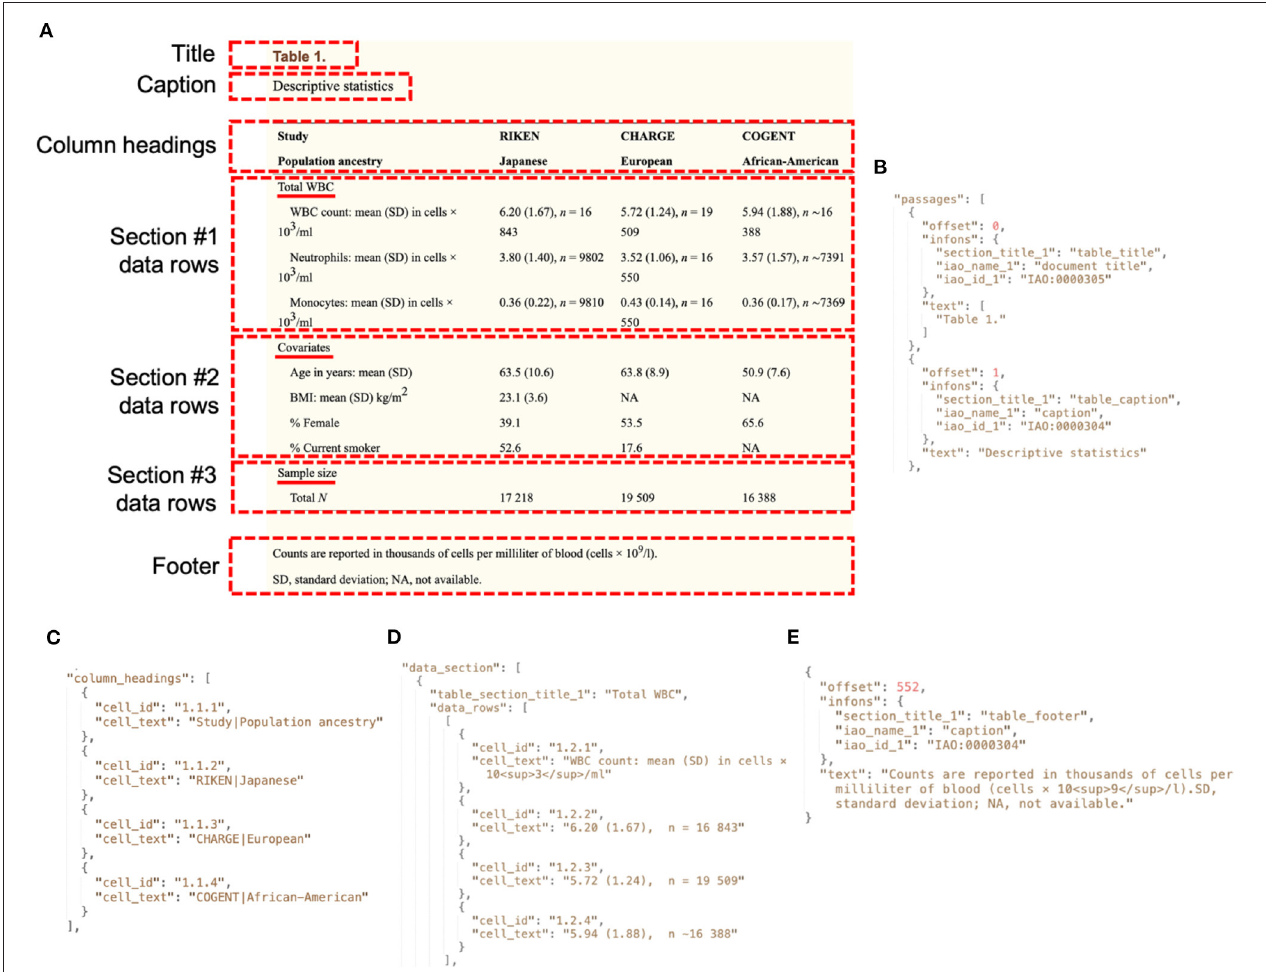
table JSON. (C) Each column heading in the table content is split between two rows, so the strings from both cells are concatenated with a pipe symbol in the table JSON. Headers that span multiple columns of sub-headers are replicated in each header cell as here with the pipe symbol. (D) The table content for the first row from the first section is shown in table JSON. Superscript characters are identified using HTML markup. (E) The footer table metadata stored in table JSON. The “autocorpus_tables.key” file describes the contents of the tables JSON file (https://github.com/omicsNLP/Auto-CORPus/blob/main/keyFiles/autocorpus_tables.key). different character encodings. A structural difference between the two outputs is in how section titles are associated to passage